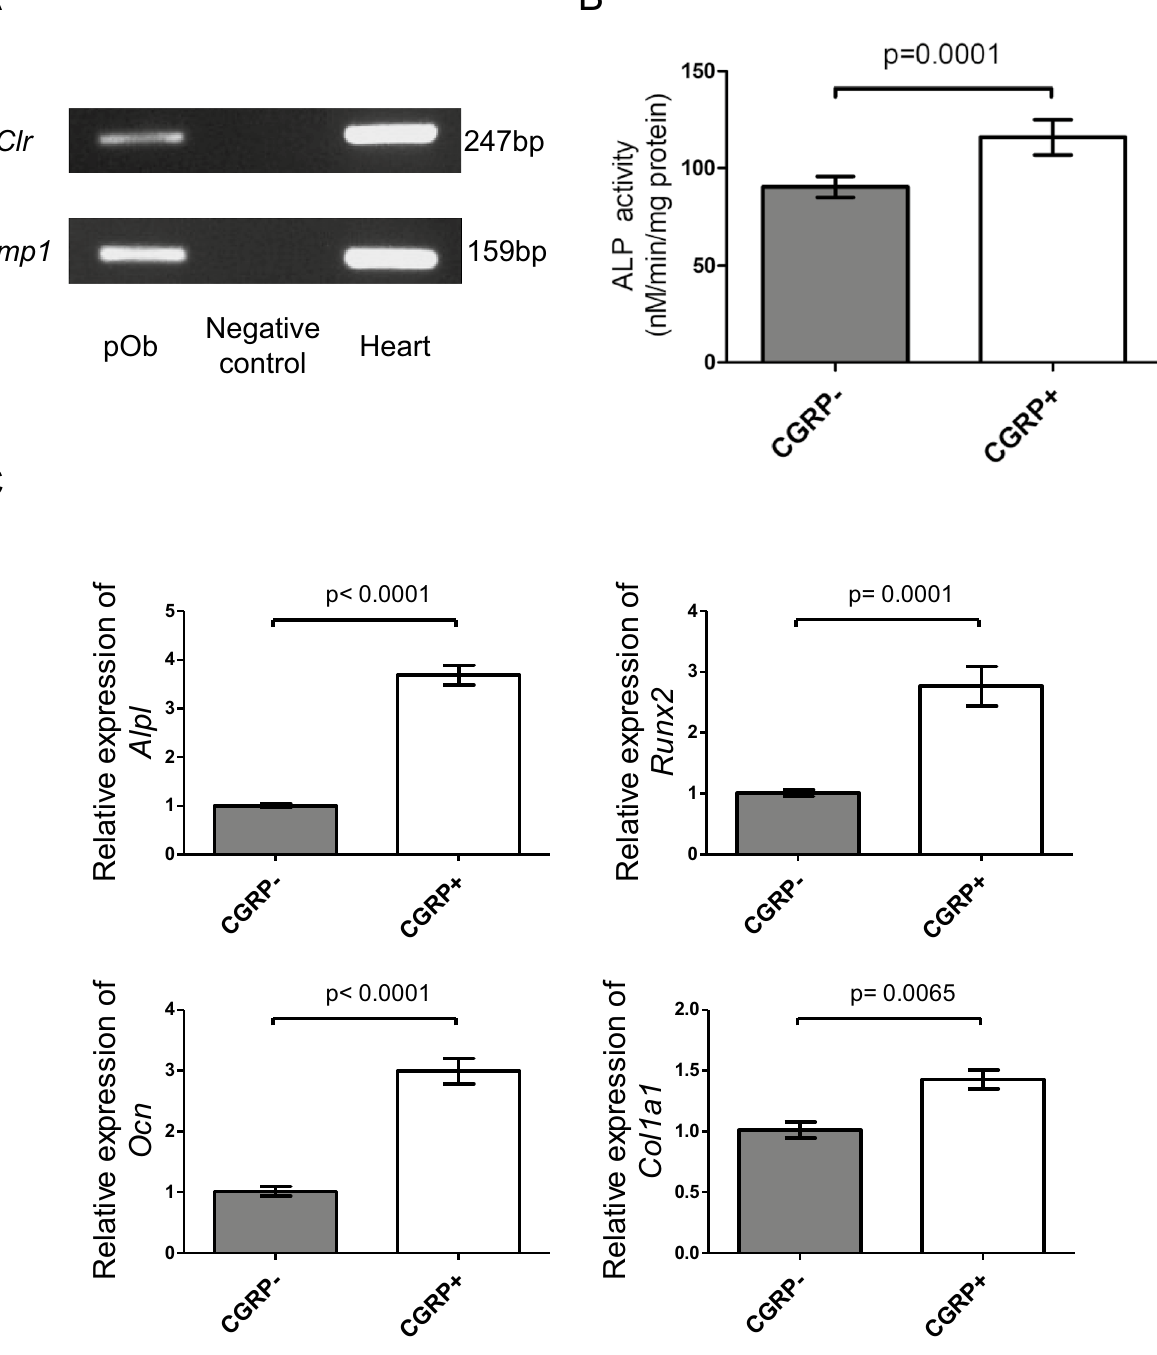
Figure 6. CGRP directly promotes osteogenesis in vitro. ( A ) Gene expression of two subunits of the CGRP receptor ( Clr and Ramp1 ) in osteoblasts detected using PCR. Clr: calcitonin gene-related peptide type 1 receptor, Ramp1: receptor activity modifying protein 1. The negative PCR control contained no RNA. Murine heart samples were used as a positive control. ( B ) ALP activity was increased in CGRP-treated primary murine osteoblasts after 4 days of osteogenic induction. ( C ) qPCR analysis showing higher expression of osteogenic genes ( Alpl , Runx2 , Ocn , and Col1a1 ) in CGRP-treated primary murine osteoblasts after 2 days of osteogenic induction. Gapdh was used as an internal control. All data are presented as the means ± SEMs (n = 6). P values were obtained using Student’s t test ( B and C